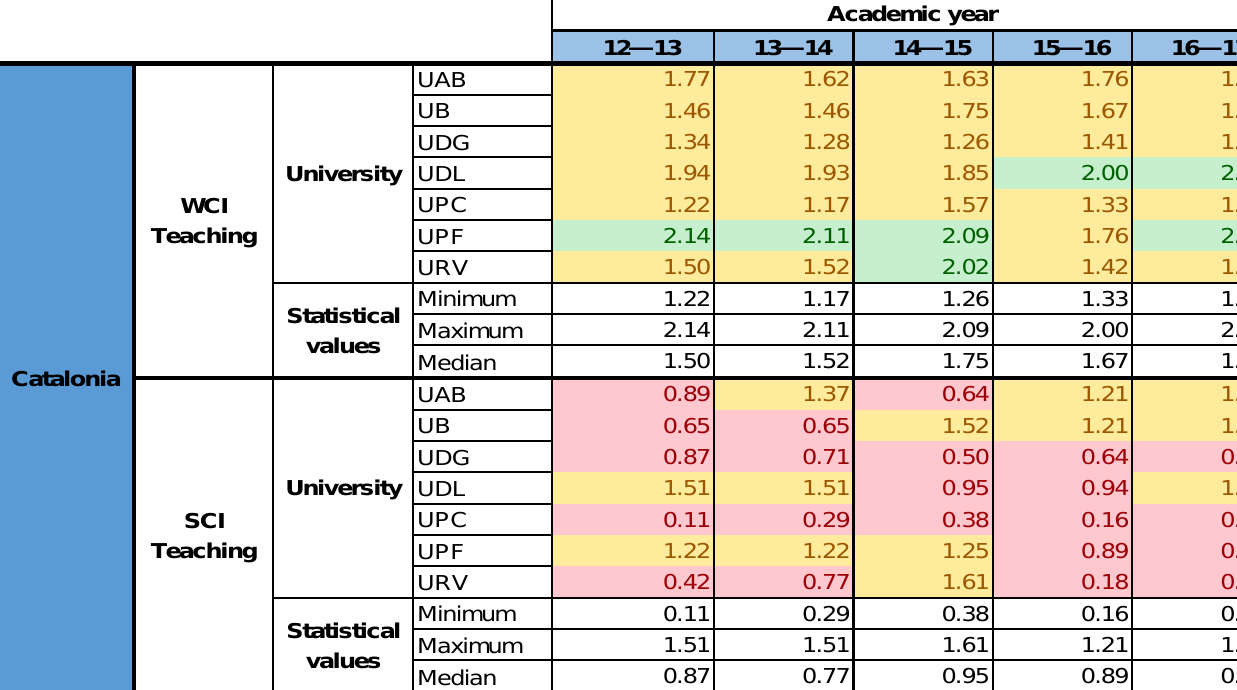
Figure A7. WCI and SCI values of the Catalan public universities in their teaching